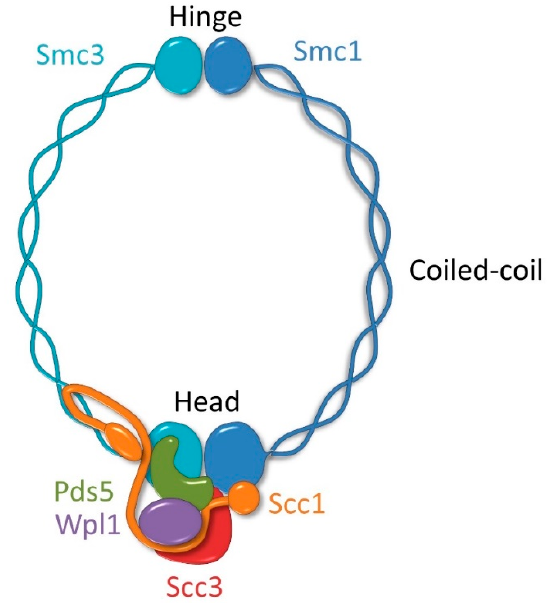
Figure 1. The cohesin complex. Cohesin is composed of Smc1 and Smc3 proteins that contain two globular domains, called the hinge and the head, separated by a long coiled-coil domain. Smc1 and Smc3 interact with each other through the hinge and the head domains. The hinge domain is the possible entry gate for the DNA while the head is an ATPase. Scc1 binds Smc3 and Smc1 with its N- and C-terminus, respectively, completing the cohesin ring. Pds5 and Scc3 are stably bound cohesin subunits that interact with cohesin through Scc1. Wpl1 binds to cohesin only temporarily through Scc3, Pds5, Scc1, and Smc3.